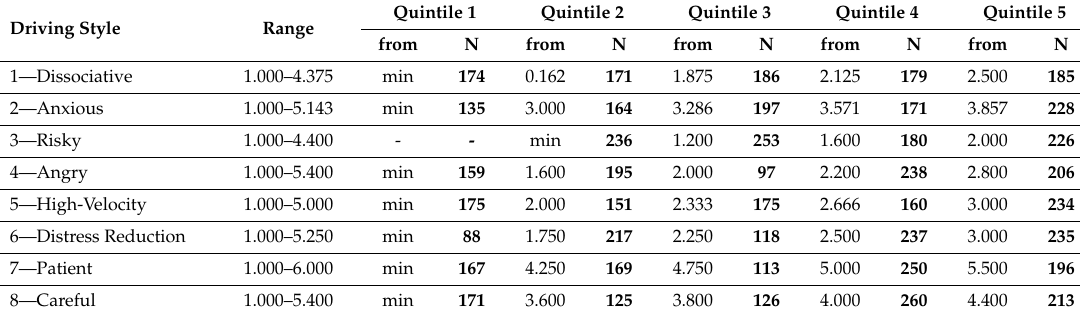
Table 9. Quintile definition by factor. N in bold is the number of data points in each category.